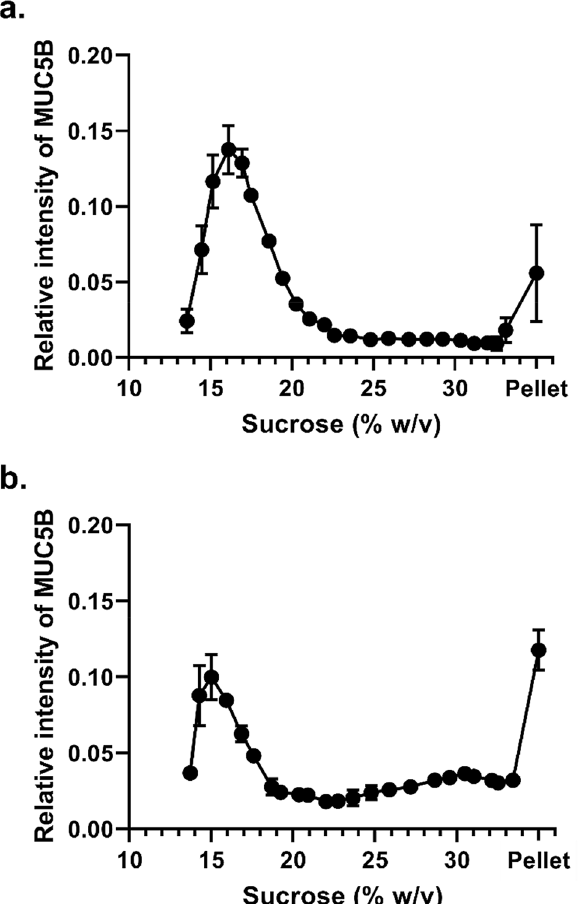
Figure 2. Dose-dependence of CsA on MUC5B sedimentation behavior. Rate-zonal centrifugation in 10–35% (w/v) sucrose gradients of purified MUC5B (200 μg/mL) with 200 μM CsA ( a ) and 2 mM CsA ( b ). Mucins were detected in sucrose gradient fractions after slot blotting by the mucin-specific antibody probe, EUMUC5B. Band intensities were quantified using the Odyssey Imaging system. The results are presented as the mean ± s.e.m. (n = 3–4) from 3 independent